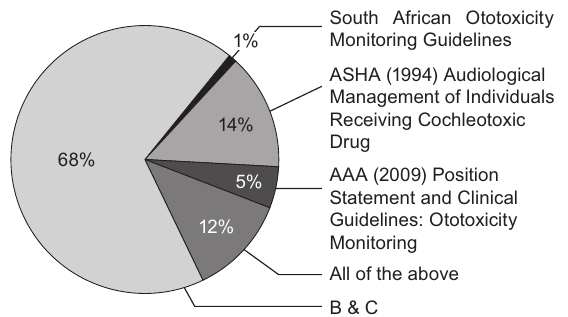
Figure 1: Awareness of the available protocols and guidelines ( n =